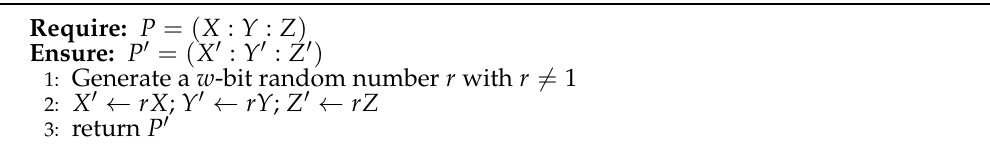
Algorithm 1: A w -bit random projective coordinate for the binary Huff curve ( w RPC)